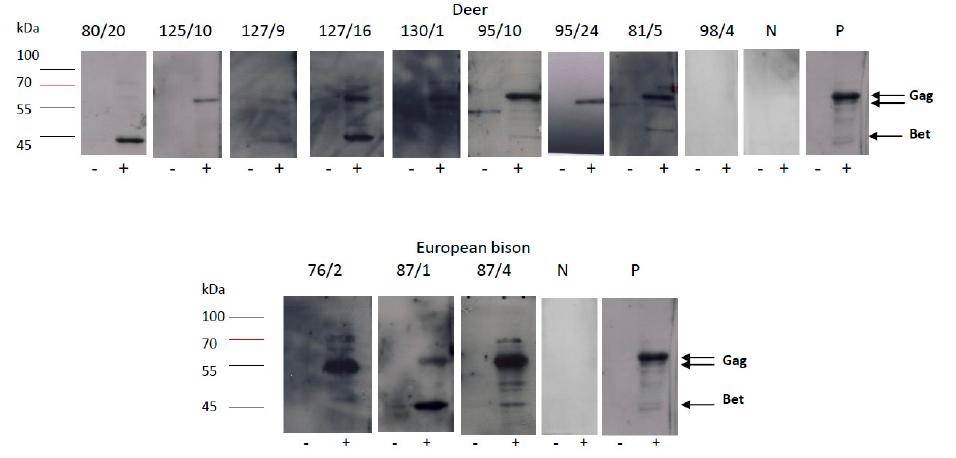
Figure 3. Detection of foamy virus (FV)-specific antibodies by immunoblotting analysis with a cellular antigen in representative serum samples of deer and European bison; ( − ) lane with uninfected Cf2Th cells lysate as antigen, ( + ) lane with Cf2Th / BFV100 cells lysate as antigen; P—BFV positive control serum, N—BFV negative serum.